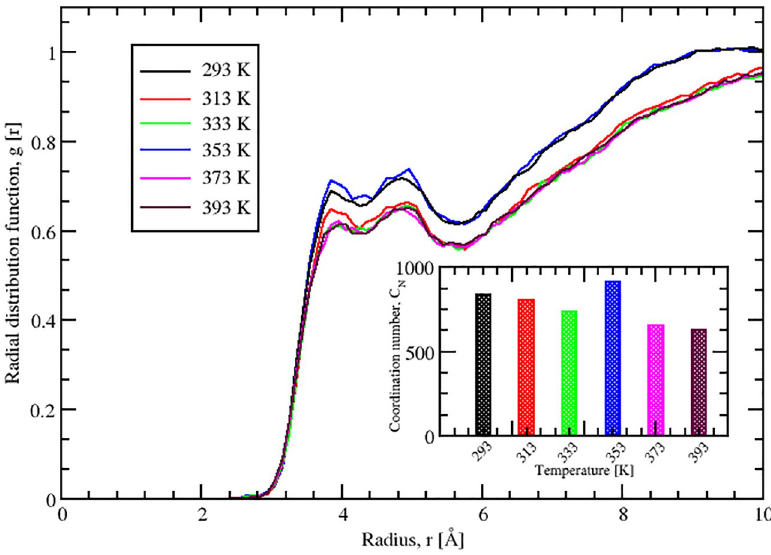
Fig 4. Radial distribution function analysis. Radial distribution function of the mass center of solvent molecules with respect to the protein surface at different temperatures. The variation of the coordination number of water molecules around the protein in the first solvation sphere with temperature is shown in the